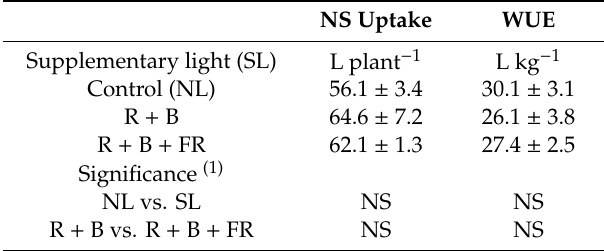
Table 4. E ff ects of light conditions (NL vs. SL) and di ff erent SL spectra (R + B vs. R + B + FR) on